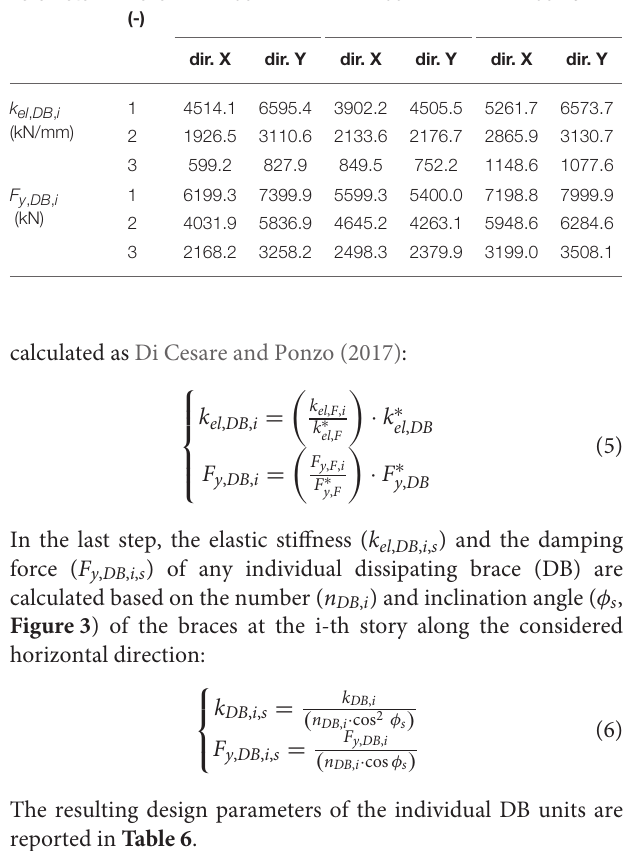
TABLE 5 | Distribution in elevation of the elastic stiffness ( k el , DB , i ) and the yielding force ( F y , DB , i ) of the DB system.